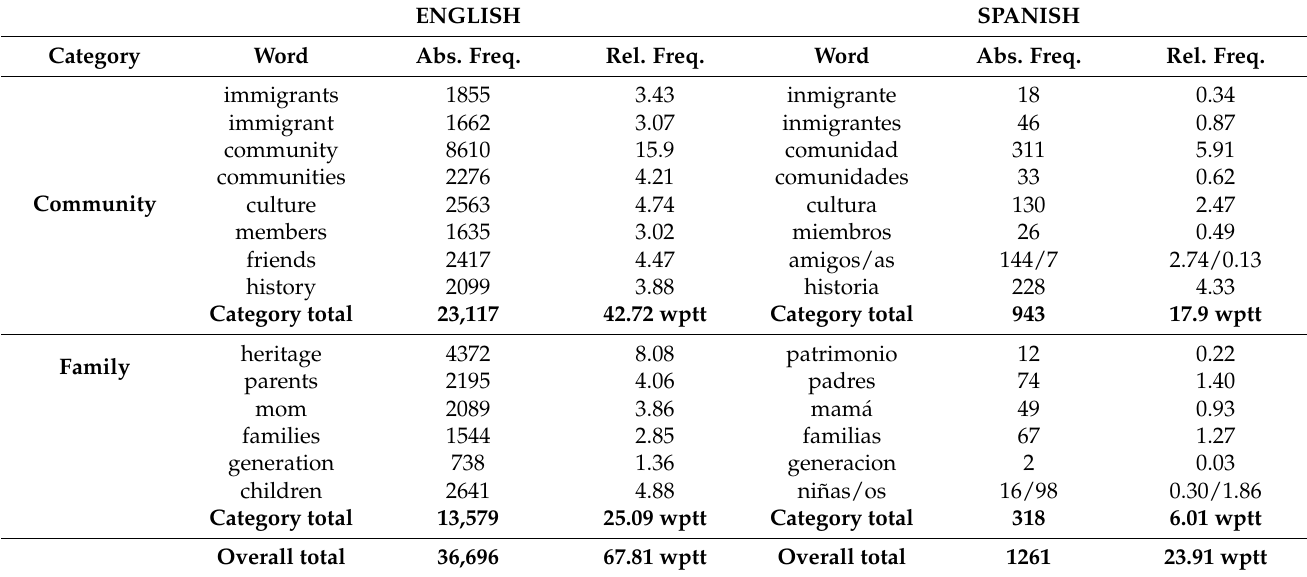
Table 2. Absolute and relative frequencies of solidarity-related descriptors in the English and the Spanish